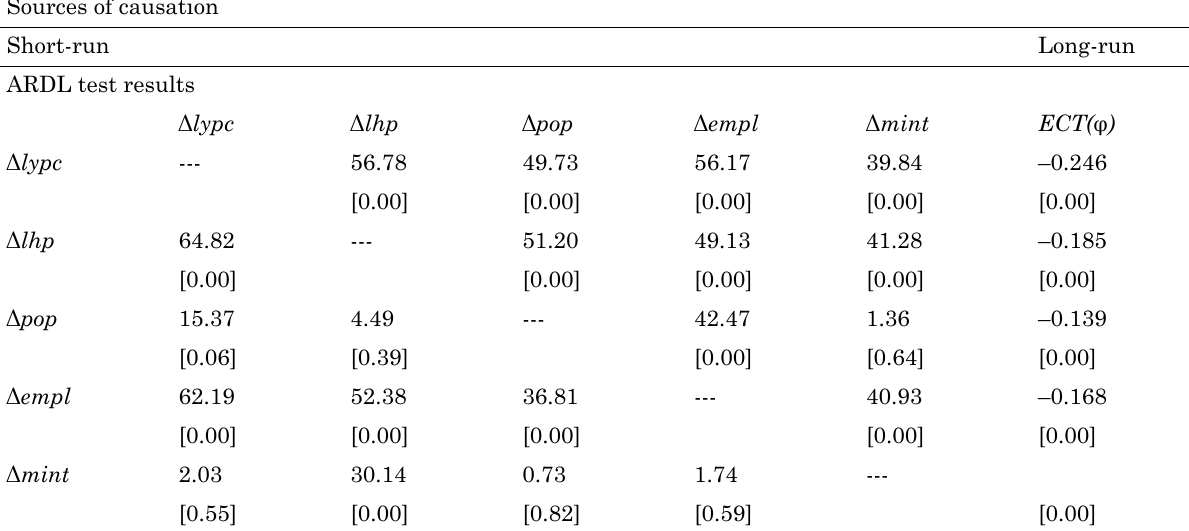
Table B5. Causality test